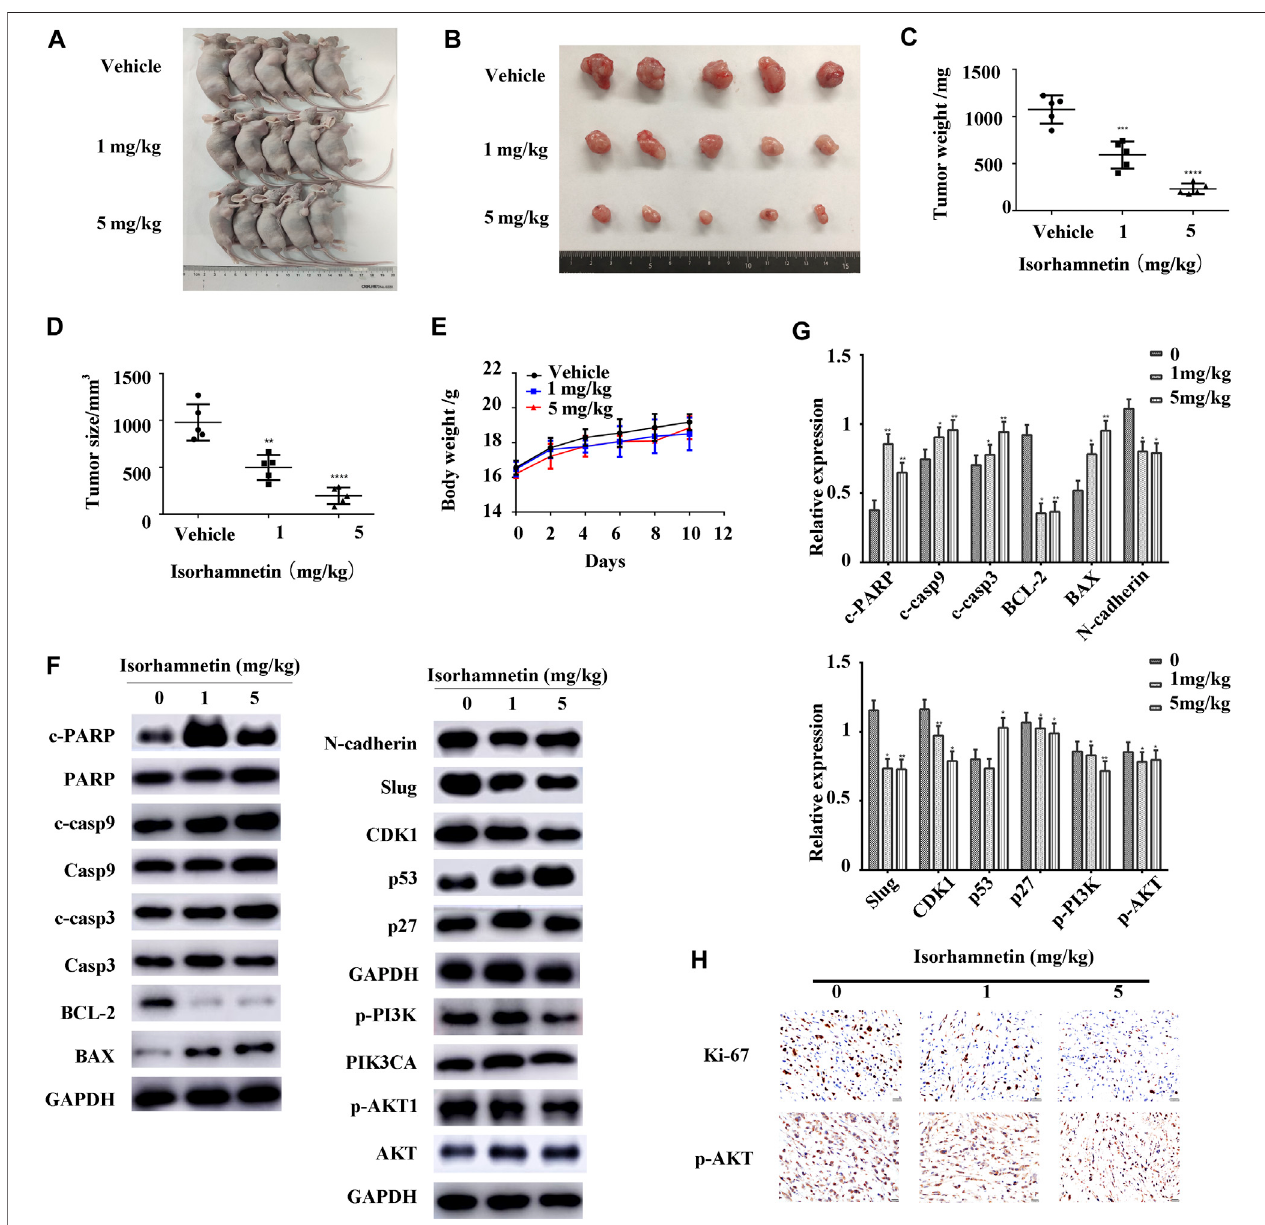
FIGURE7| Isorhamnetininhibitstumor growth invivo . (A,B) WesubcutaneouslyadministeredNOZcellsintotheright fl ankofnudemice.Wethenintraperitoneally administered0.2 mlofvehicle(1%dimethylsulfoxideand 99%cornoil)orisorhamnetin (1,5 mg/kg)tothemiceevery2 days for14 days.Necropsy imagesofmiceand tumors were then presented. (C,D) Tumor weight and size measured after tumor harvesting. *** p < 0.001 relative to the control group. (E) The body weight of mice was monitored during the experiment period. (F,G) Expression levels of p-PI3KP85 α / γ / β , PIK3CA, cleaved PARP, PARP, cleaved caspases 9, caspases 9, p27, cleaved caspases 3, caspases 3, p53, BAX, BCL-2, N-cadherin, Slug, CDK1, p-AKT1, and AKT were detected. (H) IHC staining of Ki-67 and p-AKT1 expressions in subcutaneous xenograft tumors (magni fi cation (cid:2) 400 x) ** p < 0.01, *** p < 0.001, **** p < 0.0001 relative to the control